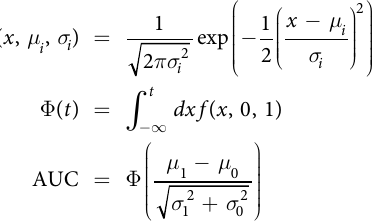
Table 4. AUCs with and without SNPs from the sex chromosomes. All tested on eMERGE using SNPs as the only